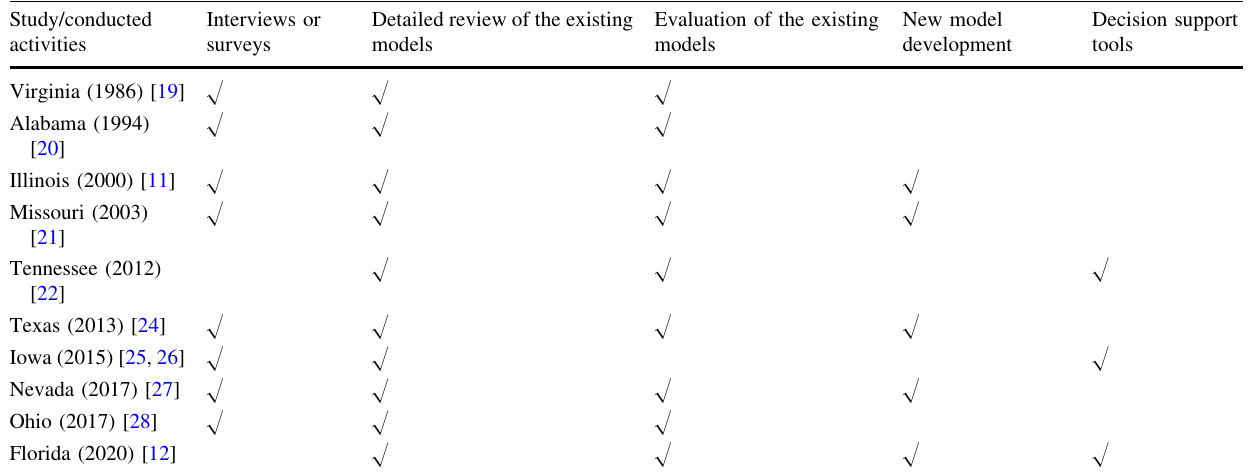
Table 2 Summary of the state DOT